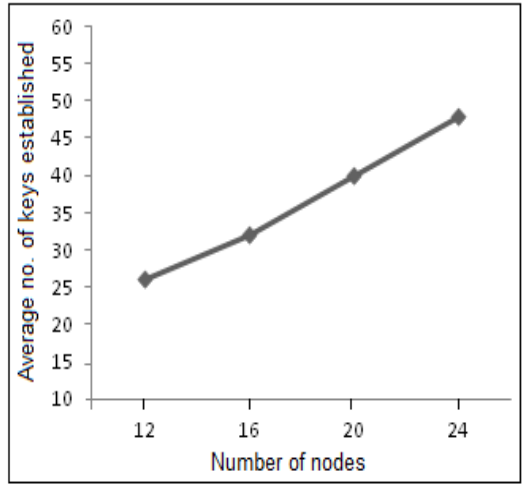
Figure 5. Average no. of keys established vs no. of nodes within network.